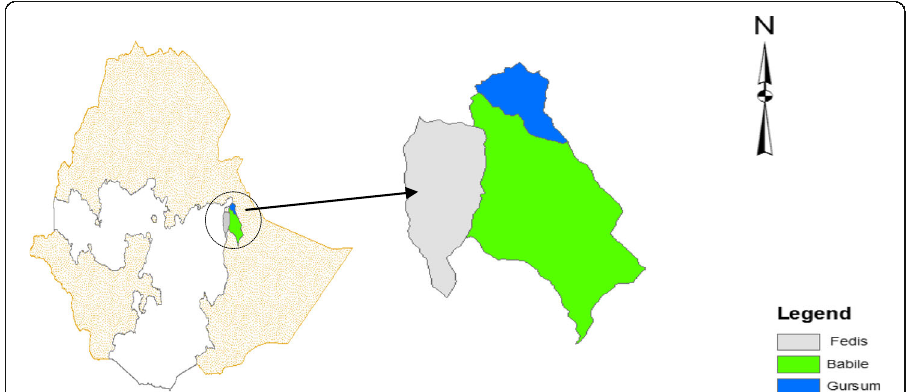
Fig. 1 Location of the study area in Oromia regional state of